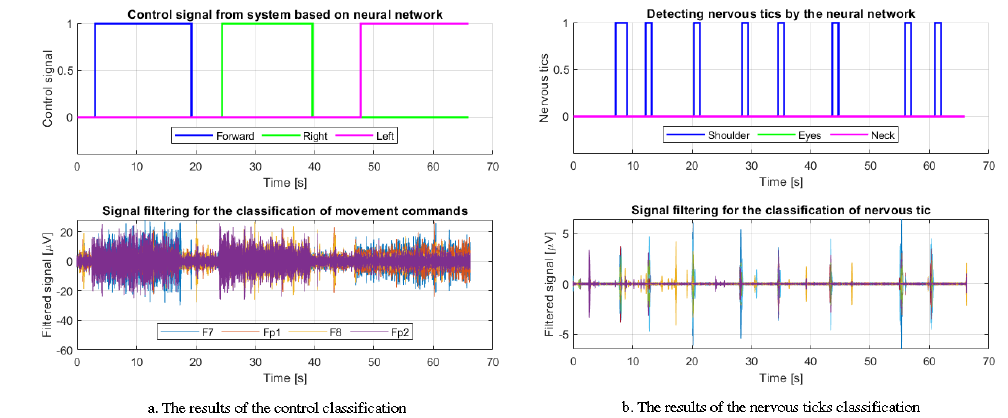
Figure 18. An example of the classification of movement commands and nervous tics—shoulder muscles tightening.